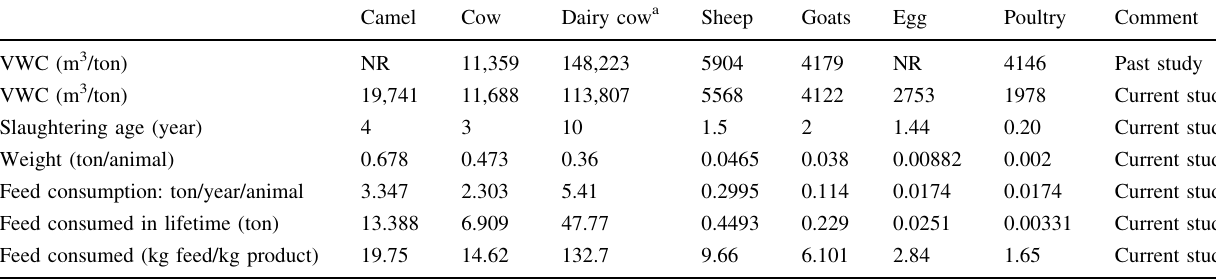
Table 8 Comparison of different livestocks in context to unit virtual water content (Riyadh region) Camel Cow Dairy cow a Sheep Goats